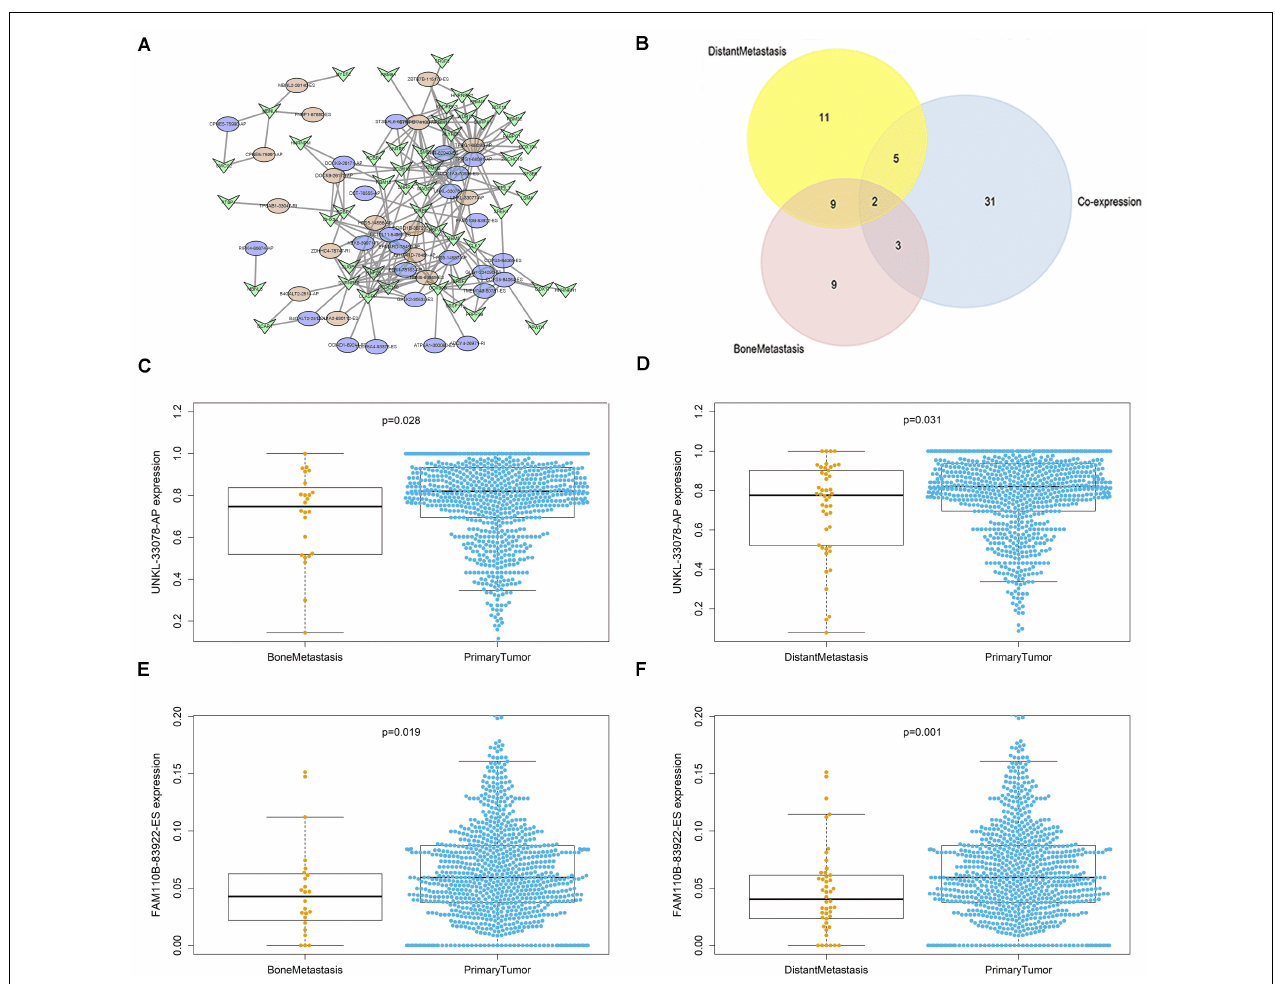
FIGURE 5 | OS-SEs related to distant metastasis and bone metastasis. (A) The network of overall-survival-associated splicing events and their co-expressed splicing factors. (B) The Venn plot of overall-survival-associated splicing events related to distant metastasis and bone metastasis. (C) The Beeswarm plot of UNKL-33078-AP expression comparing both bone metastasis and primary tumor. (D) The Beeswarm plot of UNKL-33078-AP expression comparing both distant metastasis and primary tumor. (E) The Beeswarm plot of FAM110B-83922-ES expression comparing both bone metastasis and primary tumor. (F) The Beeswarm plot of FAM110B-83922-ES expression comparing both distant metastasis and primary